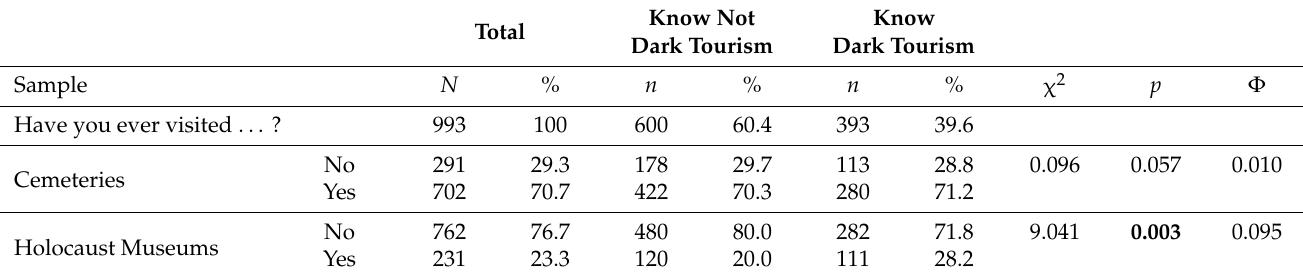
Table 2. Dark tourism